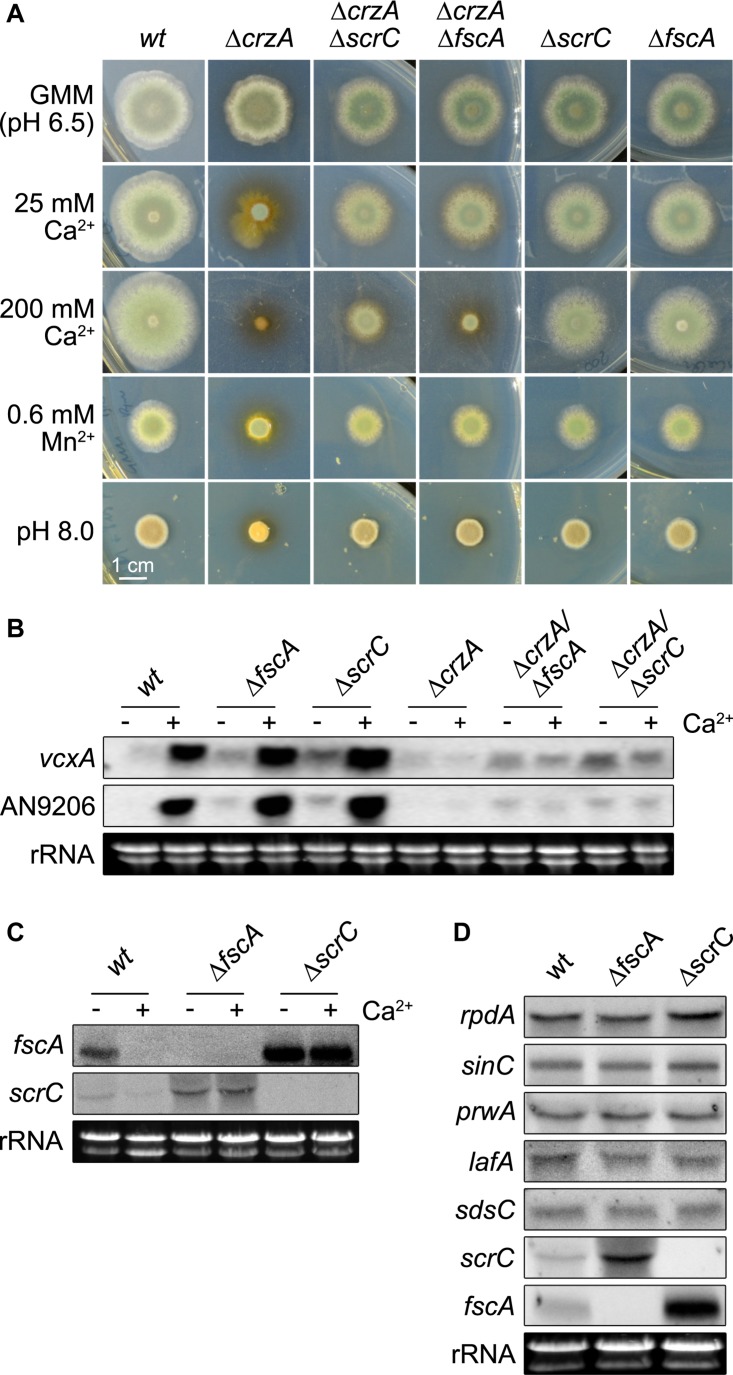
Deletion of scrC and fscA leads to ΔcrzA bypass, de-repression of Ca2+-induced genes, and loss of autoregulation. (A) Conidia (2 × 103) were point-inoculated and grown for 2 days at 37°C on MM including supplements as indicated. Representatives of at least three biological replicates are shown. Length of scale bar (1 cm) is displayed. Expression of vcxA and AN9206 (B) as well as of fscA and scrC
(C) before and after exposure to Ca2+ (50 mM) for 20 min, and of RcLS2F complex members (D) was analyzed by northern analysis in wild type and mutant strains. Fungal strains (2 × 106 conidia per ml) were grown in MM for 18 h prior induction. Expression of genes was determined using 10 μg of total RNA detected by DIG-labeled probes. Ethidium bromide stained rRNA was used as quality and loading control.